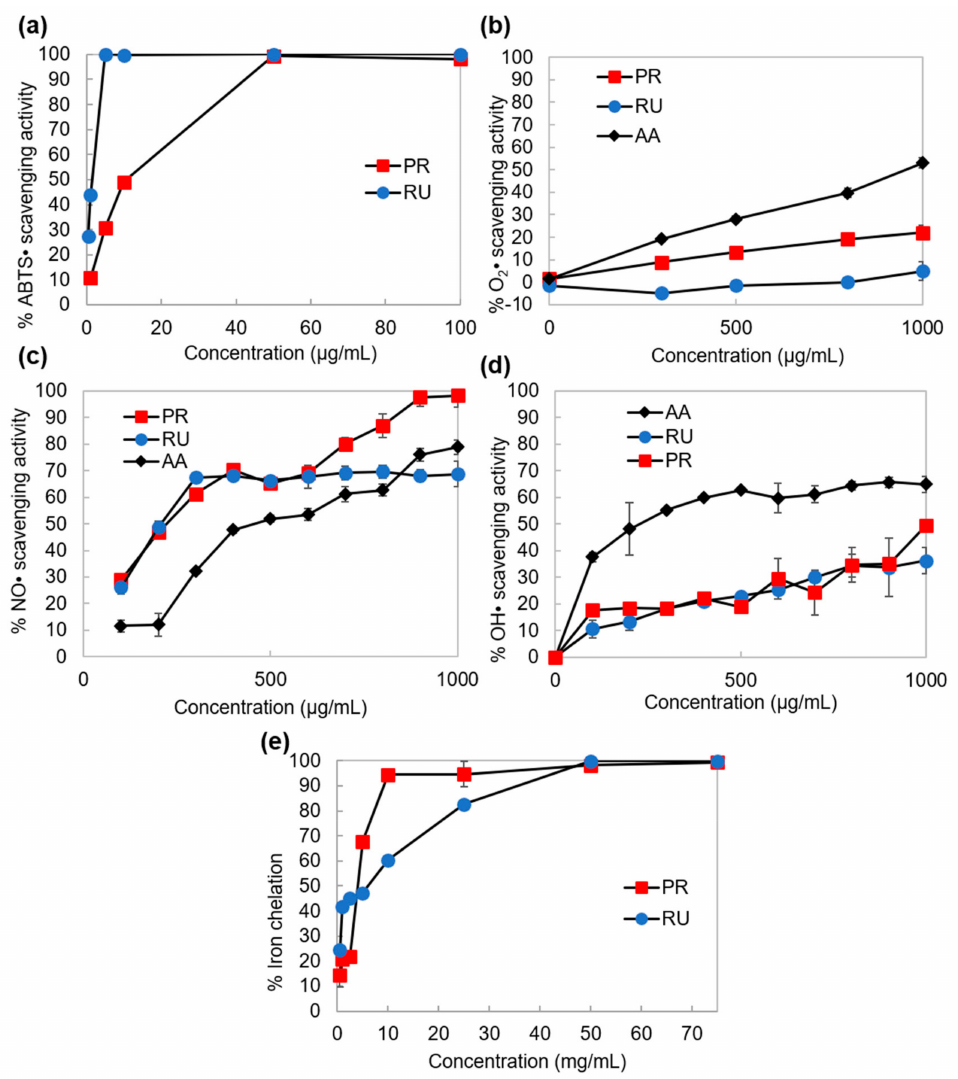
Figure 6. Antioxidant activity of RU and PR determined by the scavenging activity of ( a ) ABTS • , ( b ) O 2 • , ( c ) NO • , ( d ) OH • , and ( e ) by the Fe 2 + -chelating ability of RU and PR. Each value is expressed as a mean ± SD ( n =